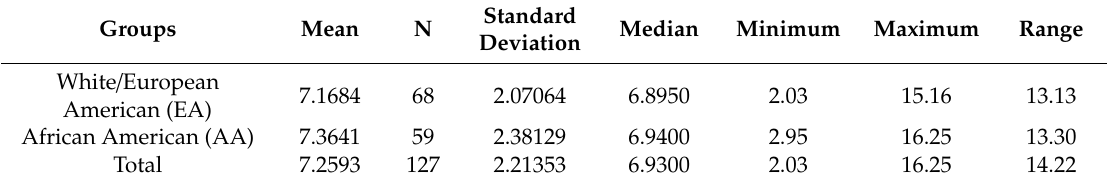
Table 3. Race specific descriptive analysis of AMY1 CNV.